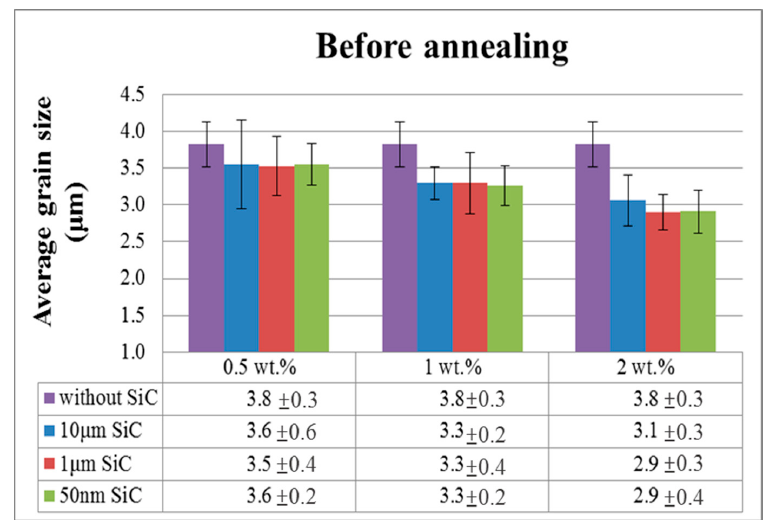
Figure 11. Average grain size of the AZ61/SiCp MMC extruded plates before annealing. Figures 12 and 13 present the metallography and average grain size of the AZ61/SiCp MMC extruded plates after annealing with different percentages and sizes of SiCp particles, respectively.